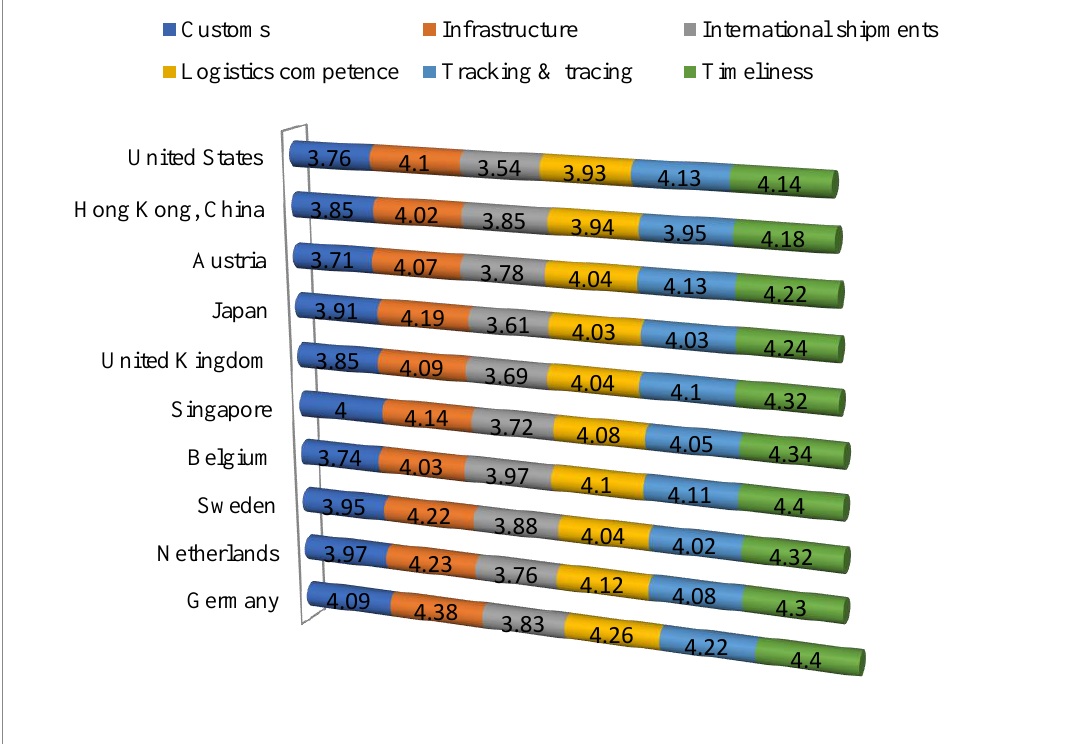
Figure 1. Top 10 Countries’ Logistics Updates in 2018. Source: World Bank [6].